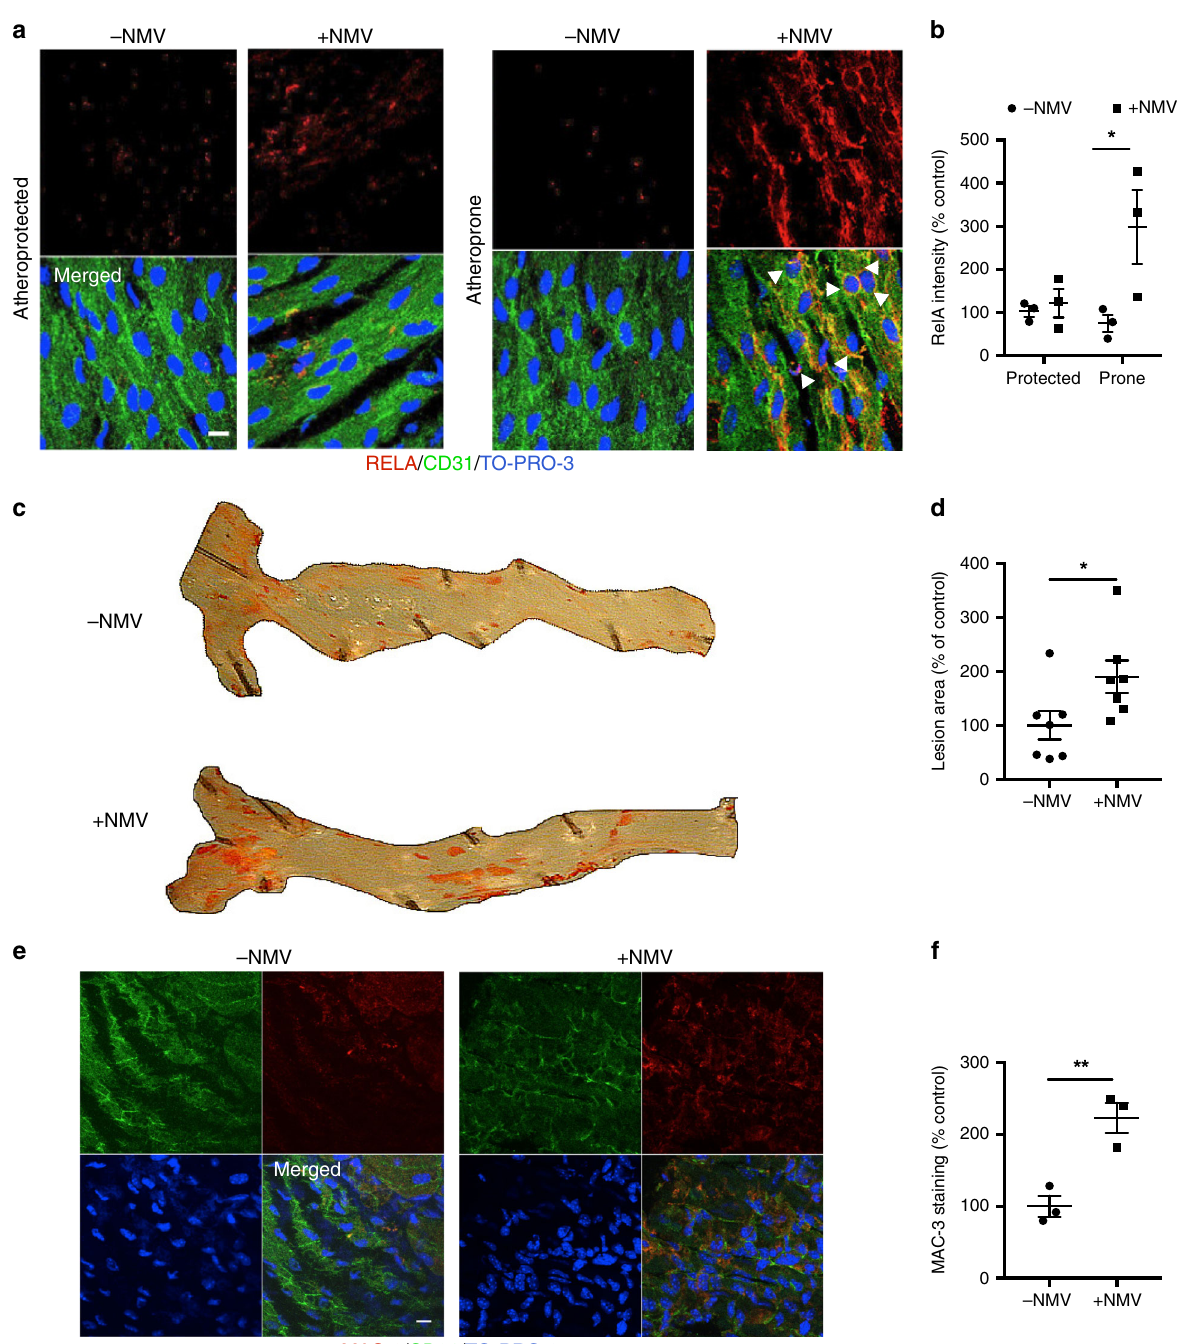
Fig. 8 NMVs induce activation of NF- κ B in atheroprone regions and enhance atherosclerosis. ApoE − / − mice fed a Western diet were injected with NMVs, or an equivalent volume of saline, twice weekly via the tail vein for 6 weeks. a Representative en face images of RELA (red) expression in the aorta of mice injected with saline ( − NMV) or NMVs ( + NMV) in atheroprone regions visualised using confocal fl uorescence microscopy. Scale bar = 10 µ m. Endothelial cells were identi fi ed by staining with anti-CD31 (green) and cell nuclei were identi fi ed using TO-PRO-3 Iodide (blue). Examples of nuclear staining of RelA indicated with arrowheads. b Mean fl uorescence intensity was quanti fi ed using ImageJ software and data expressed as mean ± SEM ( n = 5). c , d Plaque formation was measured in dissected aortae using en face Oil Red O staining and imaged by bright fi eld microscopy. c Representative images are shown. d Areas of plaque formation were determined in the entire aorta using NIS-elements analysis software ( n = 7). e , f The aortic arches of mice injected with saline ( − NMV) or NMVs ( + NMV) were studied by en face staining to quantify macrophages (MAC-3, red). e Endothelial cells were identi fi ed by staining with anti-CD31 antibody (green) and cell nuclei were identi fi ed using TO-PRO-3 Iodide (blue). Scale bar = 10 µ m. f Mean fl uorescence intensity was quanti fi ed using Image J software ( n = 3). Data are expressed as a percentage of the mean of the control samples ( − NMV) and presented as mean ± SEM. Statistical signi fi cance was evaluated using two-way ANOVA followed by Bonferroni ʼ s post hoc test ( b ) or an unpaired t -test ( d , f ). * P < 0.05, ** P < 0.01. All n numbers represent independent animals. Source data are provided as a Source Data fi